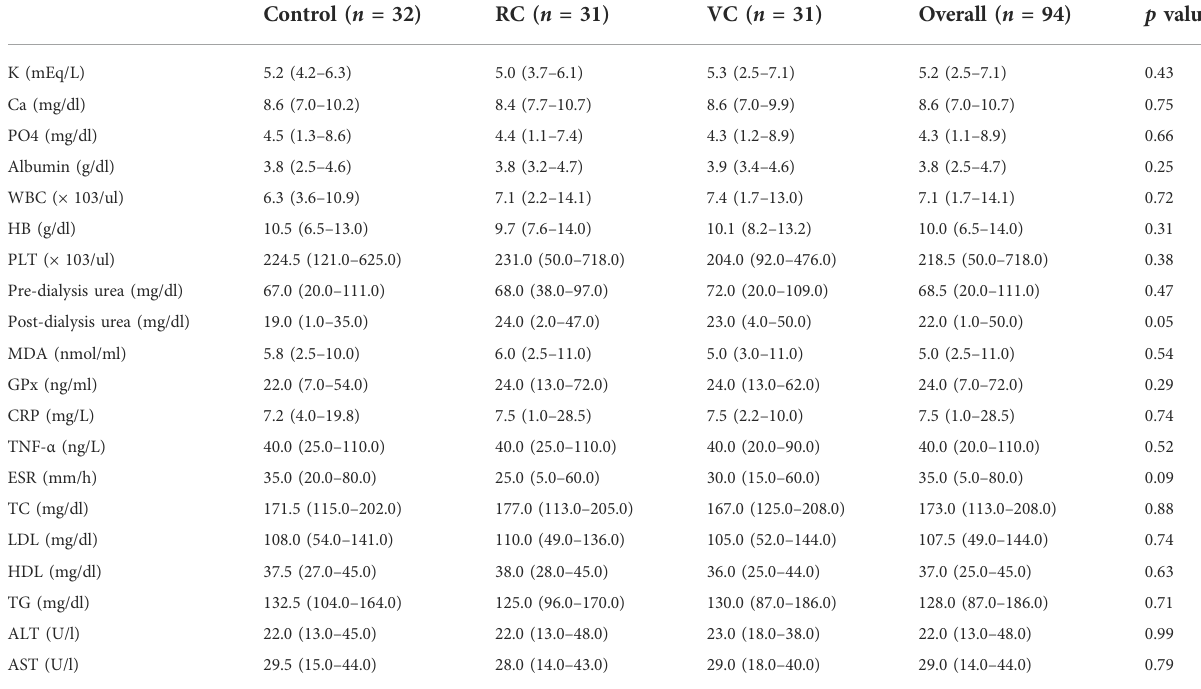
TABLE 4 Values of laboratory parameters and markers of oxidative stress at the end of the study period among the studied